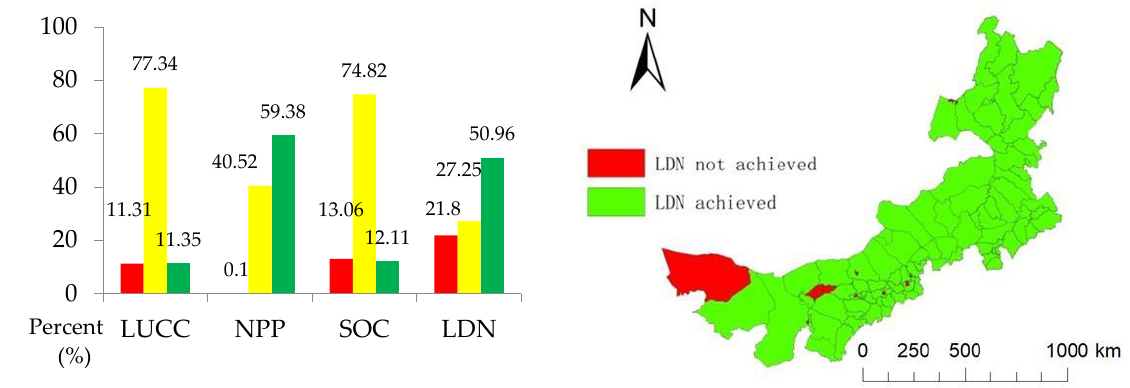
Figure 5. Indicator proportions (%) and distribution of LDN results in Inner Mongolia.